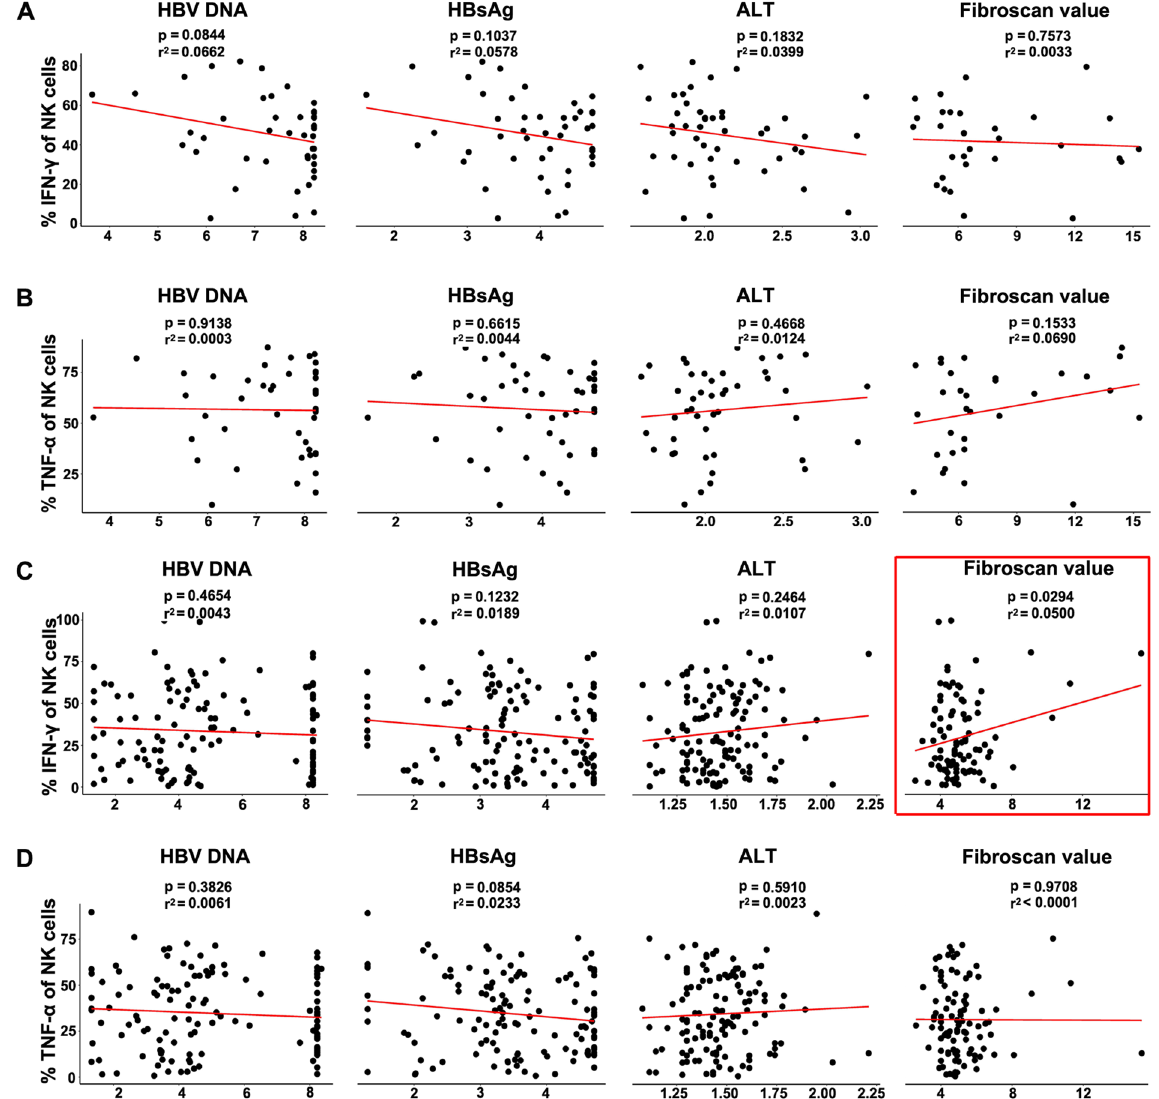
Figure 4. Correlations of clinical virology parameters with NK-cell-driven cytokine expression in CHB patients. Correlations of levels of HBV DNA, HBsAg, ALT and fibrosis, respectively, with levels of IFN- γ and TNF- α in patients in the CA ( A,B ) and CAN ( C,D ) groups. Linear regression was used to explore the correlations. The fitted curve, p value and r 2 were